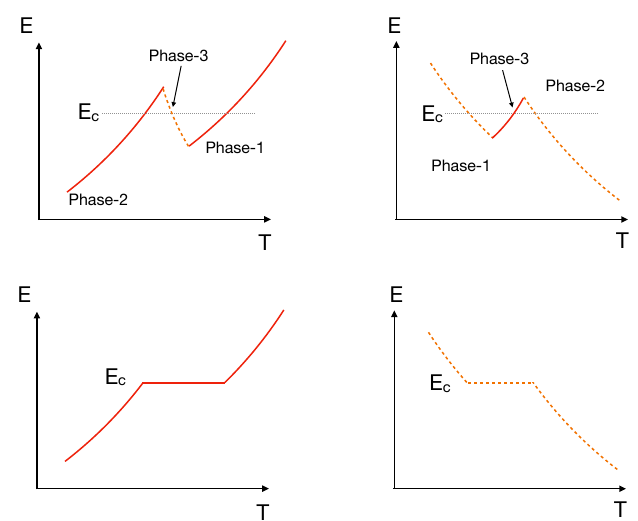
Figure 31. [Top] Coexistence of three local maxima of entropy S 1 ( E ) , S 2 ( E ) , and S 3 ( E ) in the microcanonical ensemble. We assume that S E < E c , and S 3 ( E ) is always smaller than S 1 ( E ) or S 2 ( E ) . [Bottom] Corresponding canonical phase diagram; free energy minimum (left) and maximum (right).